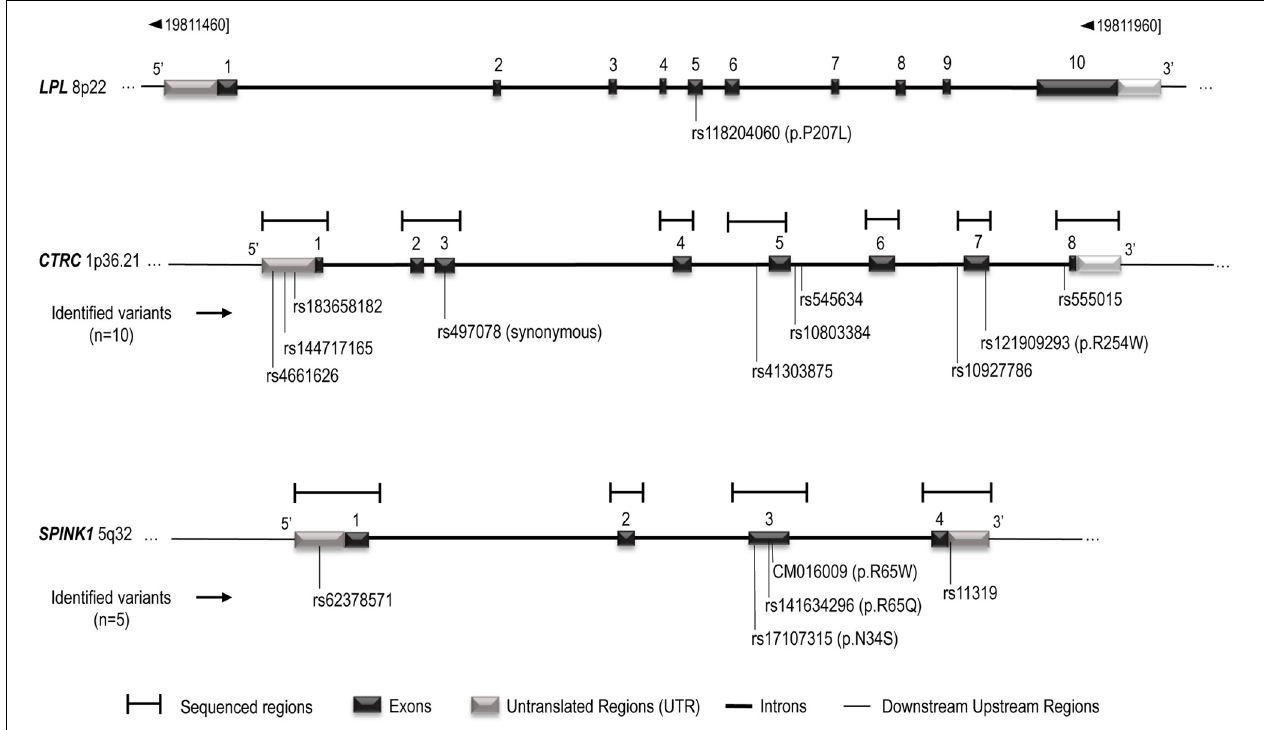
FIGURE 1 | Schematic representation of the LPL , CTRC , and SPINK1 genes structure. The gene representation is based on UCSC Genome Browser (http://genome.ucsc.edu/, February 2009, Santa Cruz, CA, USA) and Ensembl (http://uswest.ensembl.org/index.html,